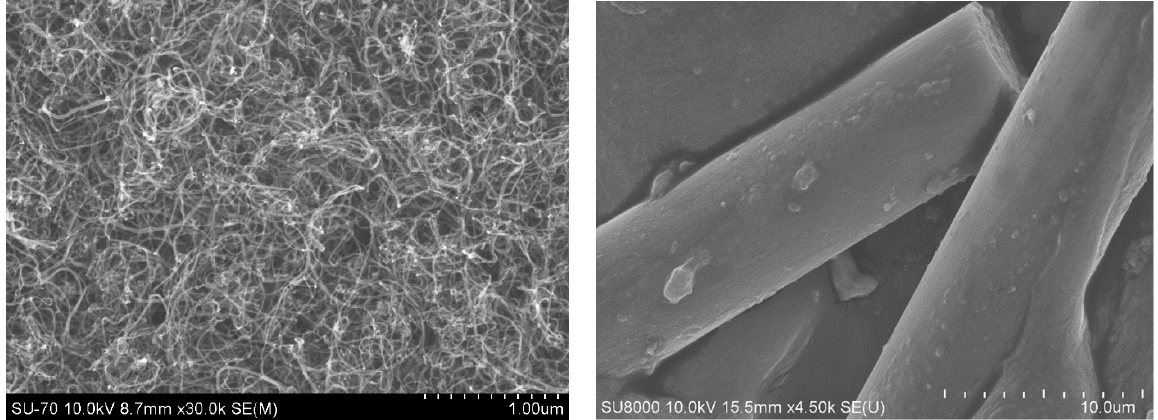
Figure 2. Scanning electron microscopy of MWCNTs ( left ) and CFs ( right ).